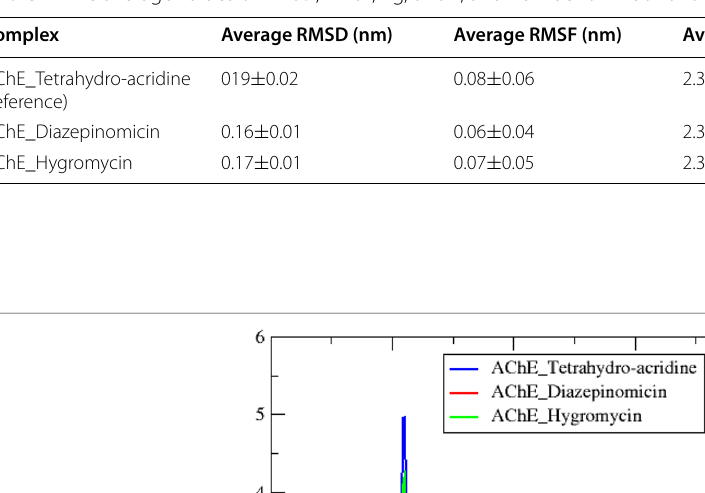
Table 4 The average values of RMSD, RMSF, Rg, SASA, and number of H-bond for the studied complexes